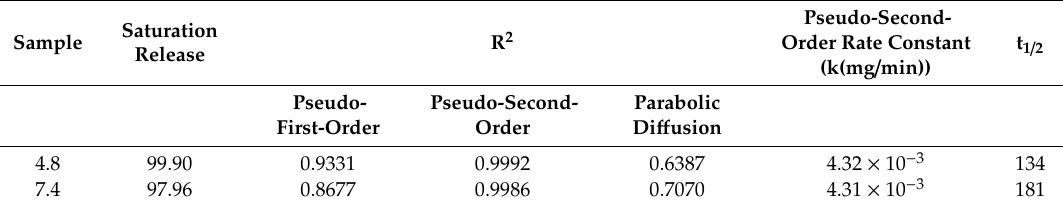
Table 2. The correlation coe ffi cient, rate constant, and half-life obtained by fitting the sorafenib release data into the PBS solution at pH 4.8 and pH